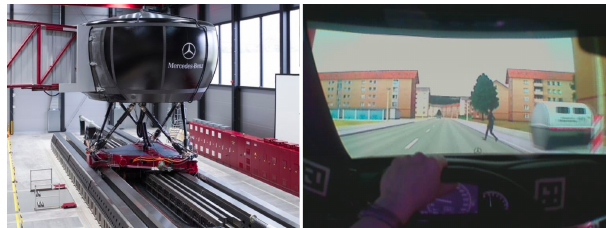
Figure 2 . Moving base driving simulator. The entire cabin is mounted on a hexapod, moving along the 12m rail result- ing in up to 1g acceleration force. Virtual reality showing a pedestrian crossing the lane. Figures provided by Daimler